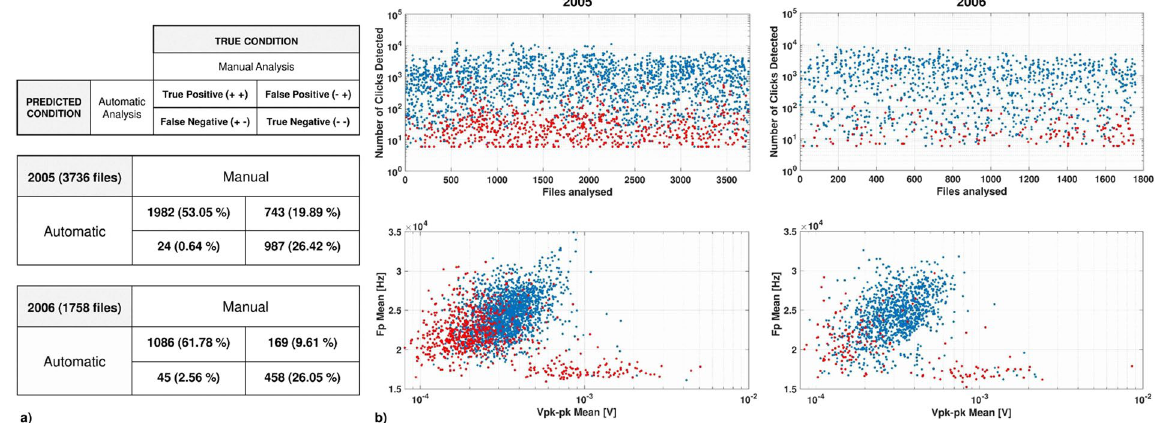
Figure 2. Biosonar detection. ( a ) Confusion matrix shows the comparison between the Manual analysis ( True condition ) and the Automatic analysis ( Predicted condition ). Performance of the algorithm is showed for recordings acquired in 2005 and 2006. In 2005, TP rate (TP/P) was 72%, FP rate (FP/N) was 67%, FN (FN/P) rate was 0.8% and TN (TN/N) rate was 97%. In 2006, they were 86%, 33%, 3.5% and 91% respectively. ( b ) ( top ) Number of clicks recorded per file during 2005 and 2006. ( bottom ) Mean Amplitude ( x-axis , peak to peak) and mean Frequency Peak ( y-axis ) of the clicks selected in each file. Recordings classified as False Positive are marked in